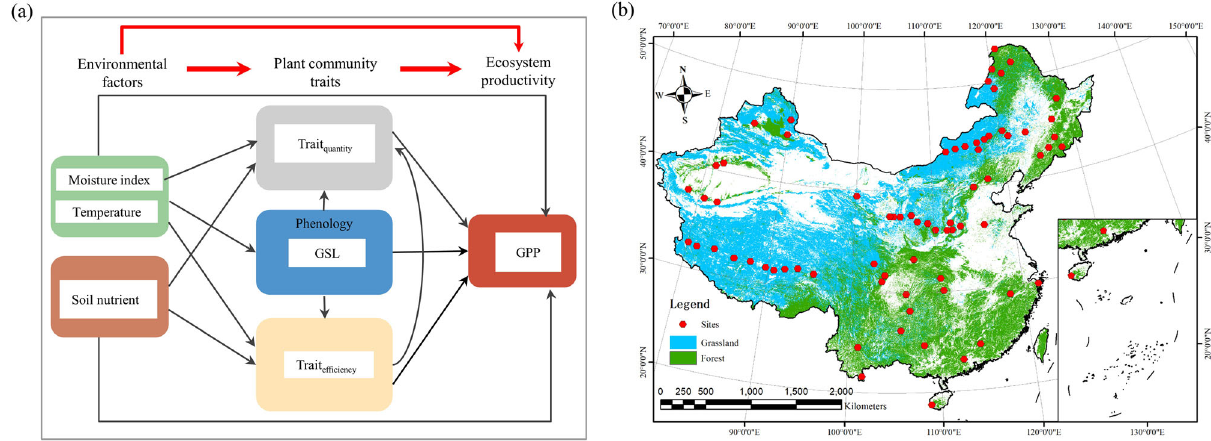
Fig. 2 Technology roadmap including conceptual model and sampling sites distribution in thie study. Conceptual model depicting linkages among the environmental factors and plant community traits affecting the variation in GPP ( a ) and geographic distribution of study sites ( b ).Trait quantity and Trait ef fi ciency : quantity and ef fi ciency traits, respectively; GSL: growing-season length (months). The map of sample distribution was created using ArcGIS